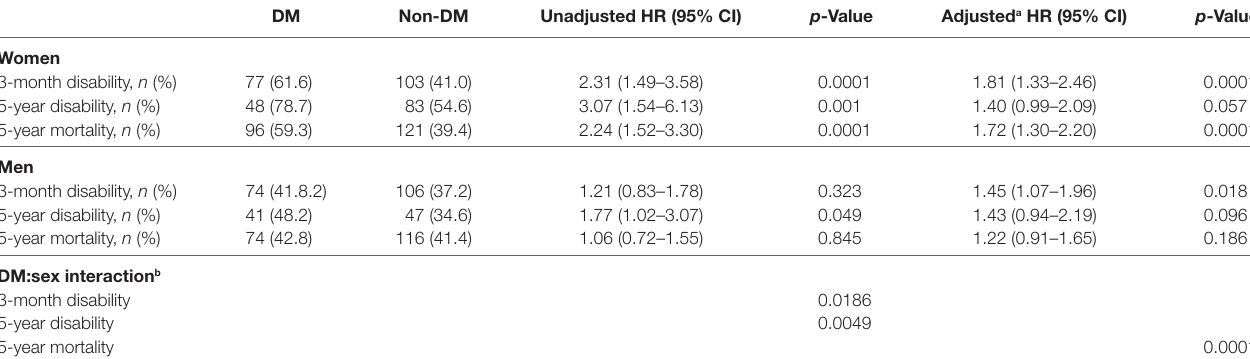
TaBle 3 | Outcome parameters comparing diabetic women with non-diabetic women and diabetic men with non-diabetic men. DM